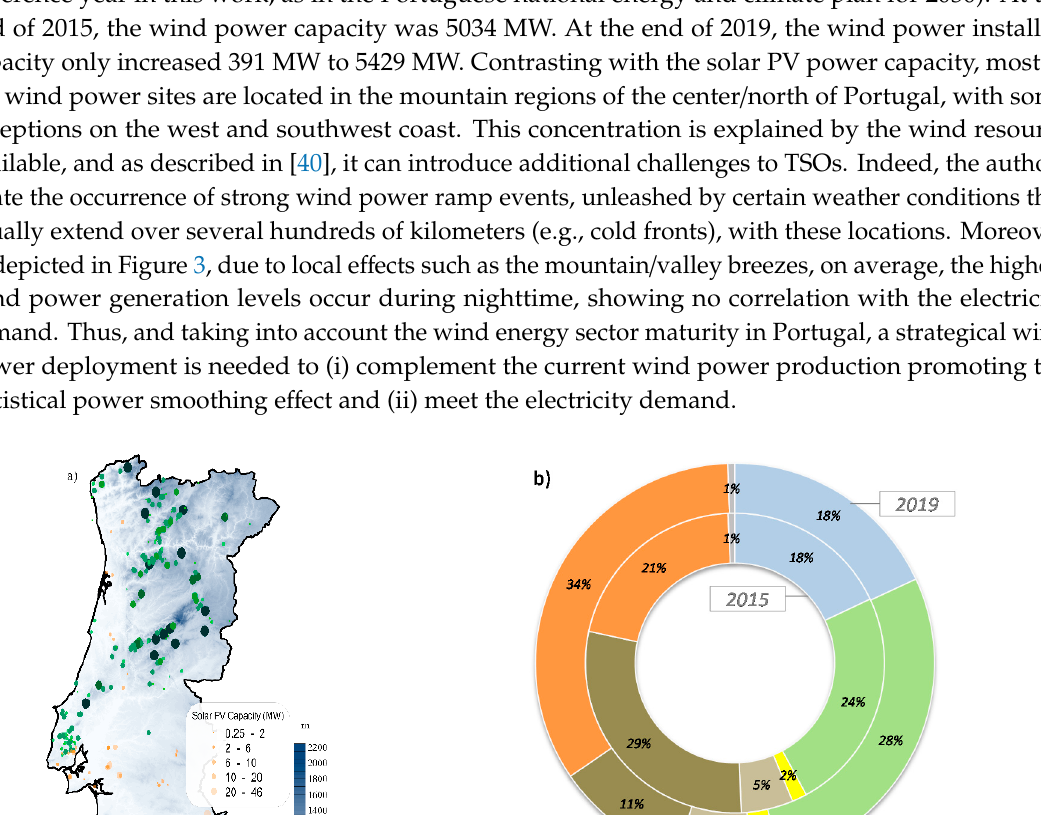
Figure 3. National aggregated daily average power production (green—wind; orange—solar PV), demand (black), and net load (gray) during 2015. As identified for other phenomena (e.g., precipitation [42]), due to the geographical location, along with its topographical features and weather conditions, different regional wind and solar power production patterns can be observed in Portugal [43]. The atmospheric circulation in Portugal is strongly influenced by the seasonal migration of the mid-latitude high pressure system [44]. In winter, when the subtropical high pressure is usually centered at lower latitudes, warm and cold fronts and other baroclinic synoptic perturbations moving eastward from the Atlantic Ocean are observed. In late spring to early autumn, the western perturbations are blocked by this subtropical system that expands to higher latitudes (typically centered in the Azores). Under these conditions,